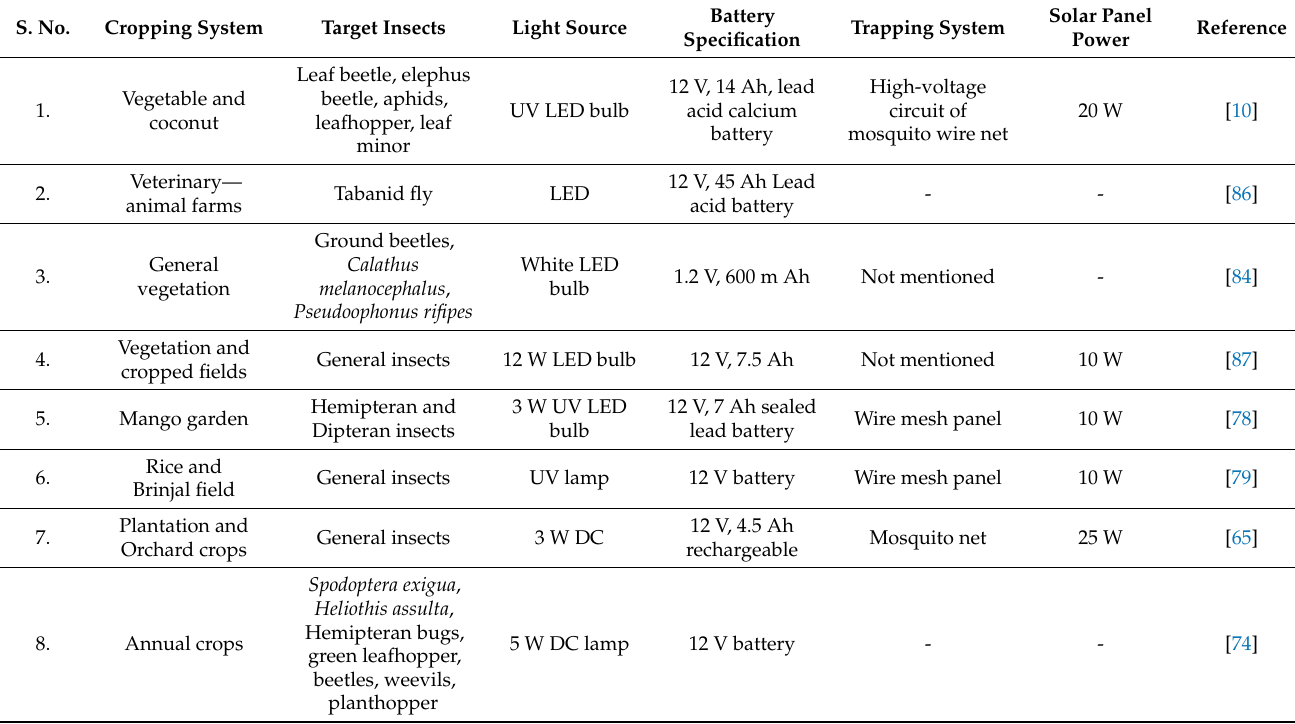
Table 2. Details of the solar insect traps tested for different